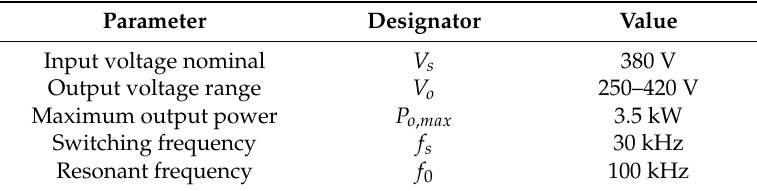
Table 3. Design specification of the proposed